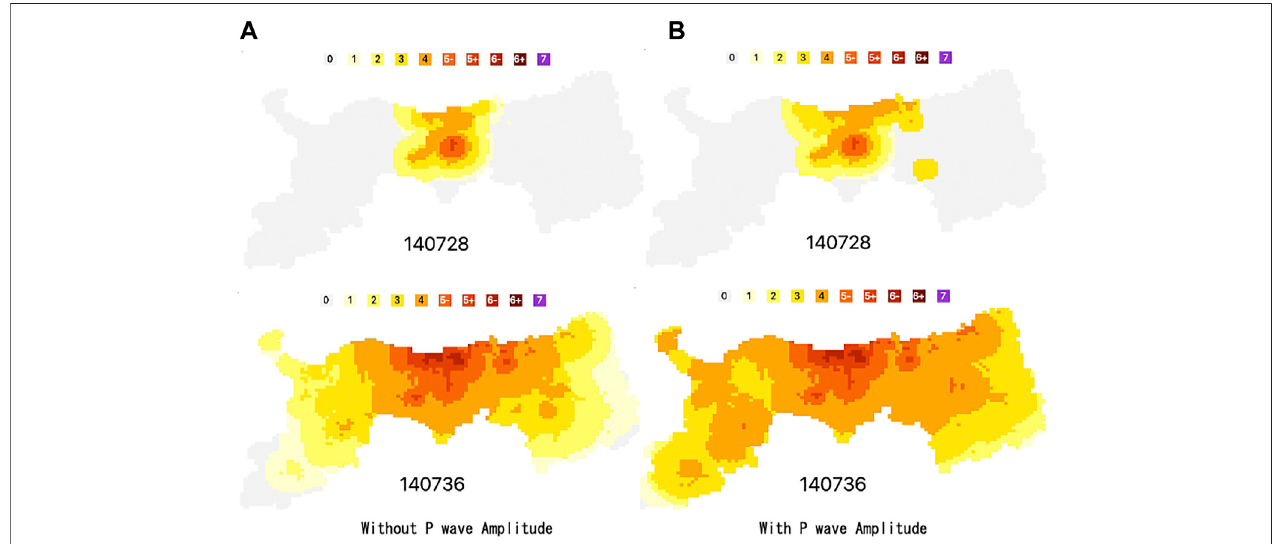
FIGURE 11 | Same as Figure 10 but for the 2018 Western Shimane Prefecture Earthquake.